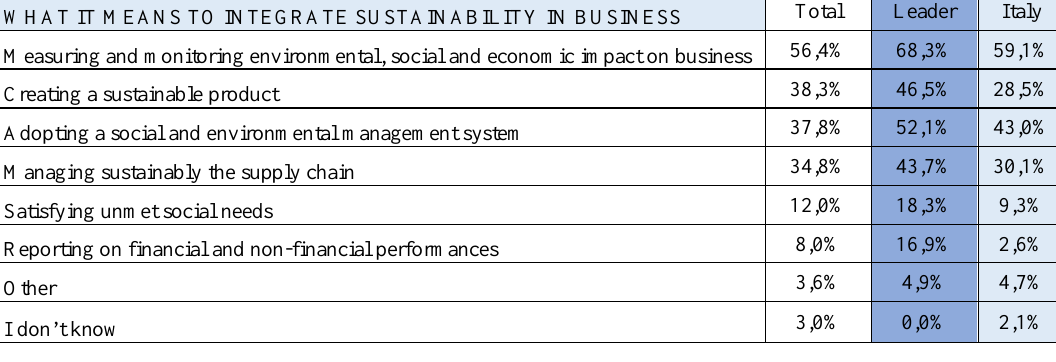
WHAT IT MEANS TO INTEGRATE SUSTAINABILITY IN BUSINESS Measuring and monitoring environmental, social and economic impact on